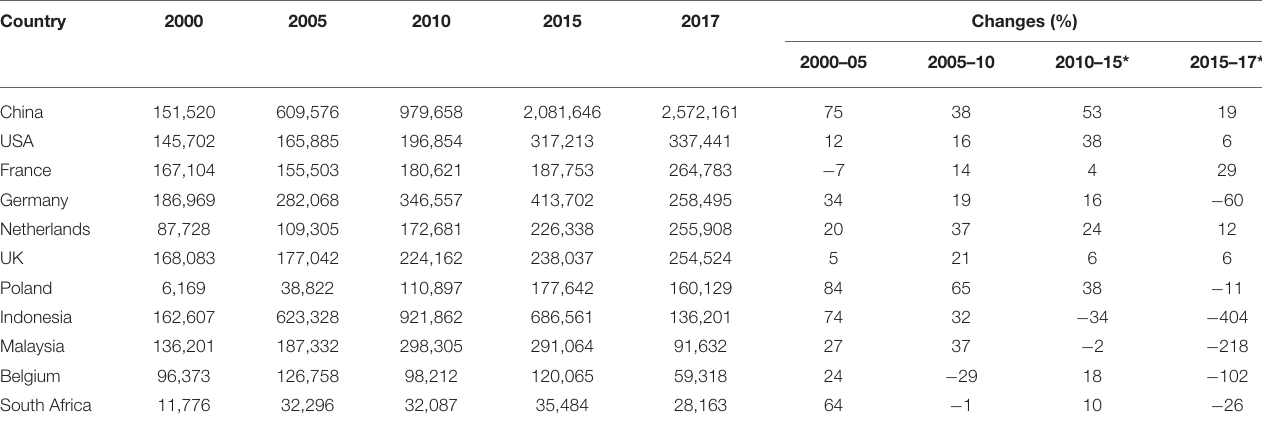
TABLE 3 | World leading starch importers (in ton).